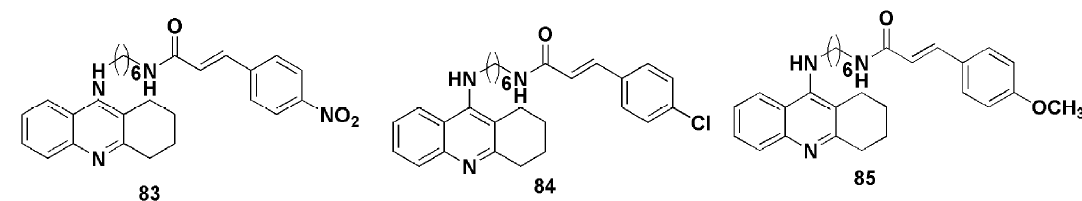
Figure 21. Chemical structures of novel tacrine-cinnamic acid hybrids [59].